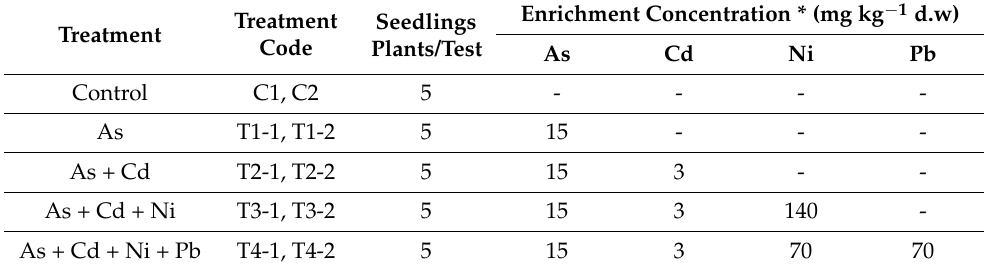
Table 1. Applied treatment. Treatment